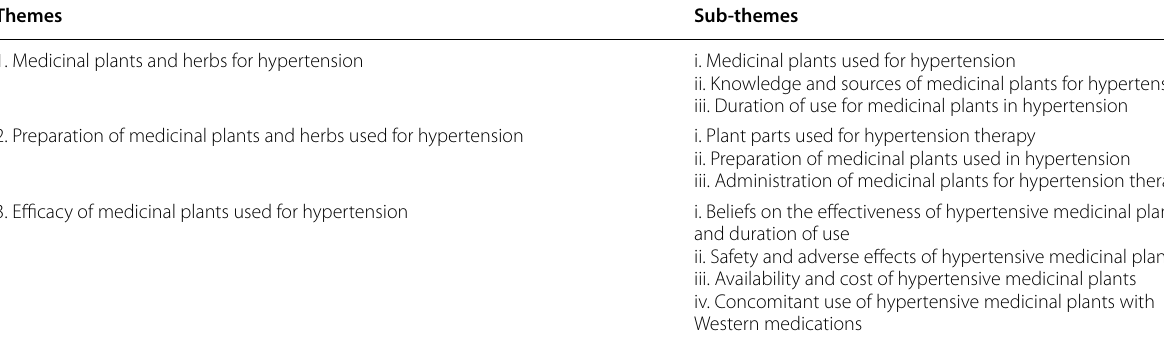
Table 1 Themes and sub-themes revealed during data analysis of hypertensive patients